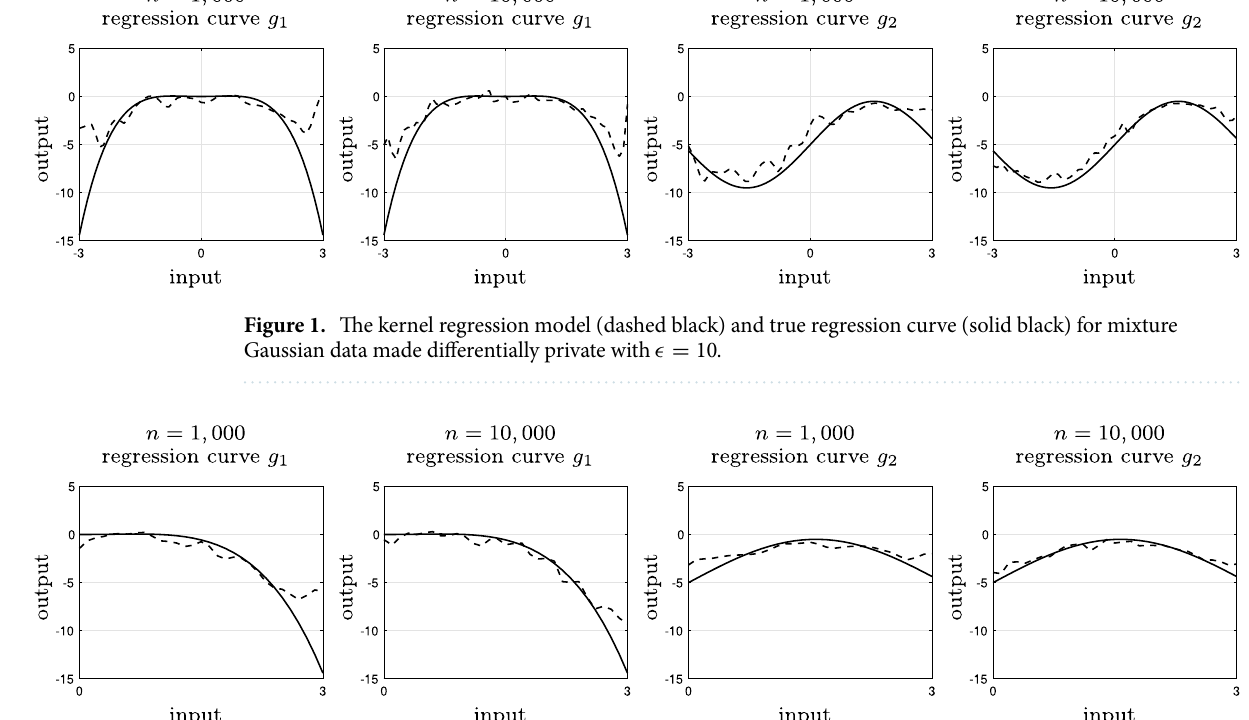
Figure 2. The kernel regression model (dashed black) and true regression curve (solid black) for chi-squared data made differentially private with ǫ